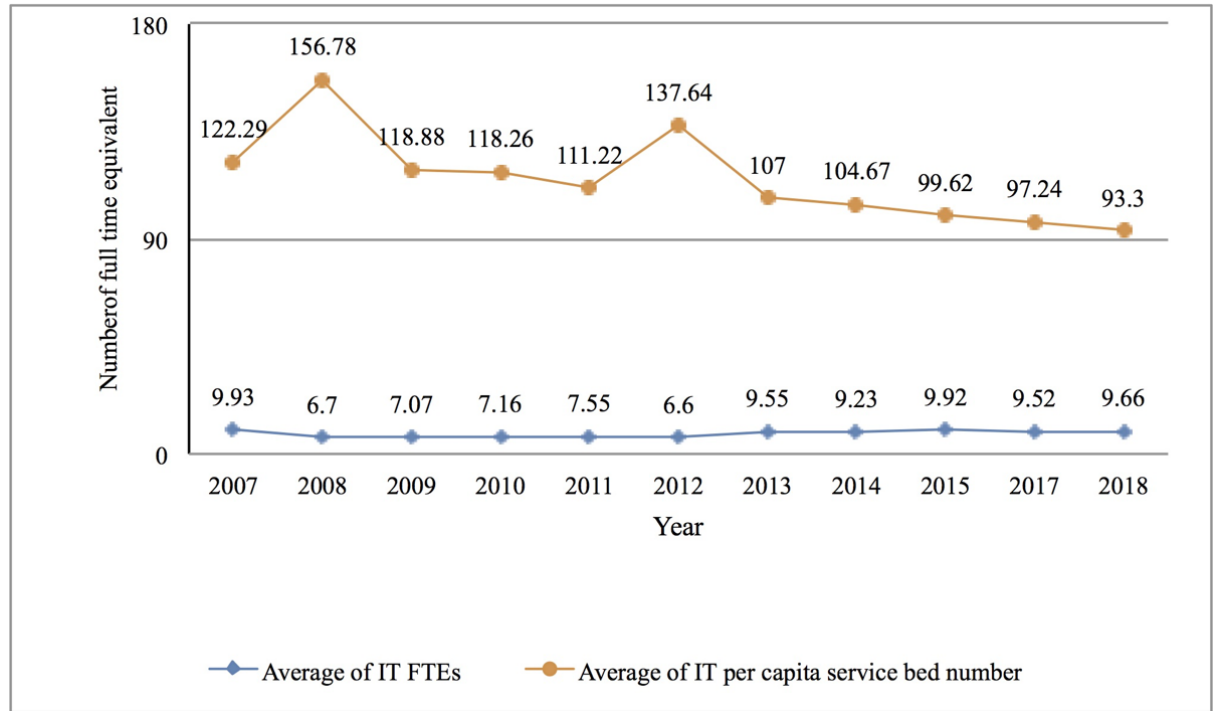
Figure 3. Proportion of human resources in China’s hospital information technology centers from 2007 to 2018. FTE: full-time equivalent; IT: information technology.